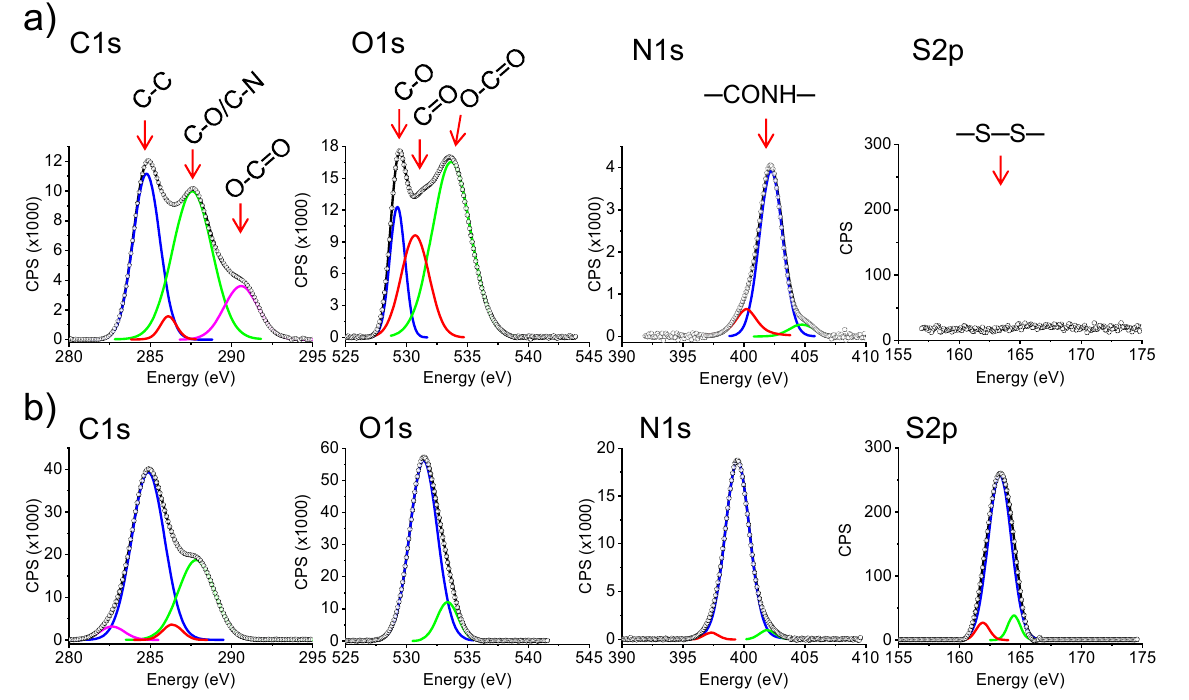
Figure 6. C 1s, O 1s, N 1s and S 2p high resolution XPS spectra for γ -PGA electrospun fibers ( a ) and hydrogel from electrospun fibers crosslinked with the theoretical stoichiometric amount of cystamine ( b ). Deconvolution of the spectra is also shown to indicate the presence of different types of atoms. The hydrogel preparation method highly affected on the water uptake, being this higher for samples prepared from the electrospun fibers than for the bulk for a given theoretical crosslinking degree. Obviously, water uptake decreased with the increase of the crosslinking density. Porosity, surface tension and the amount of available area for contacting water play an important role to determine the solvent uptake (SU). Experimental values were calculated from the weights of the swollen (W s ) and lyophilized (W d ) hydrogels (Equation (1)):